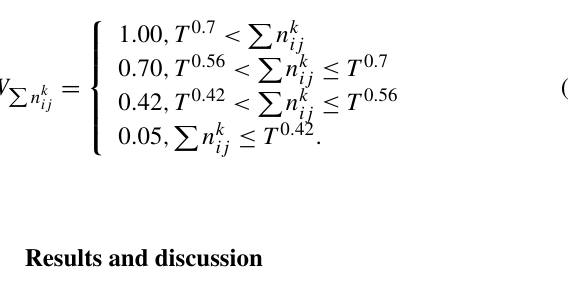
as below (Guo et al.,